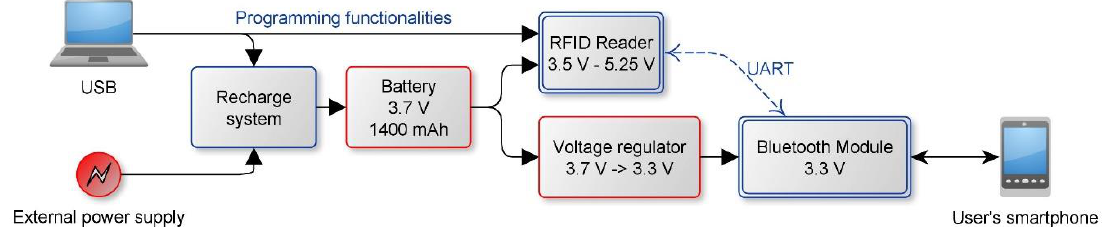
Figure 1. Block diagram of the hardware architecture.